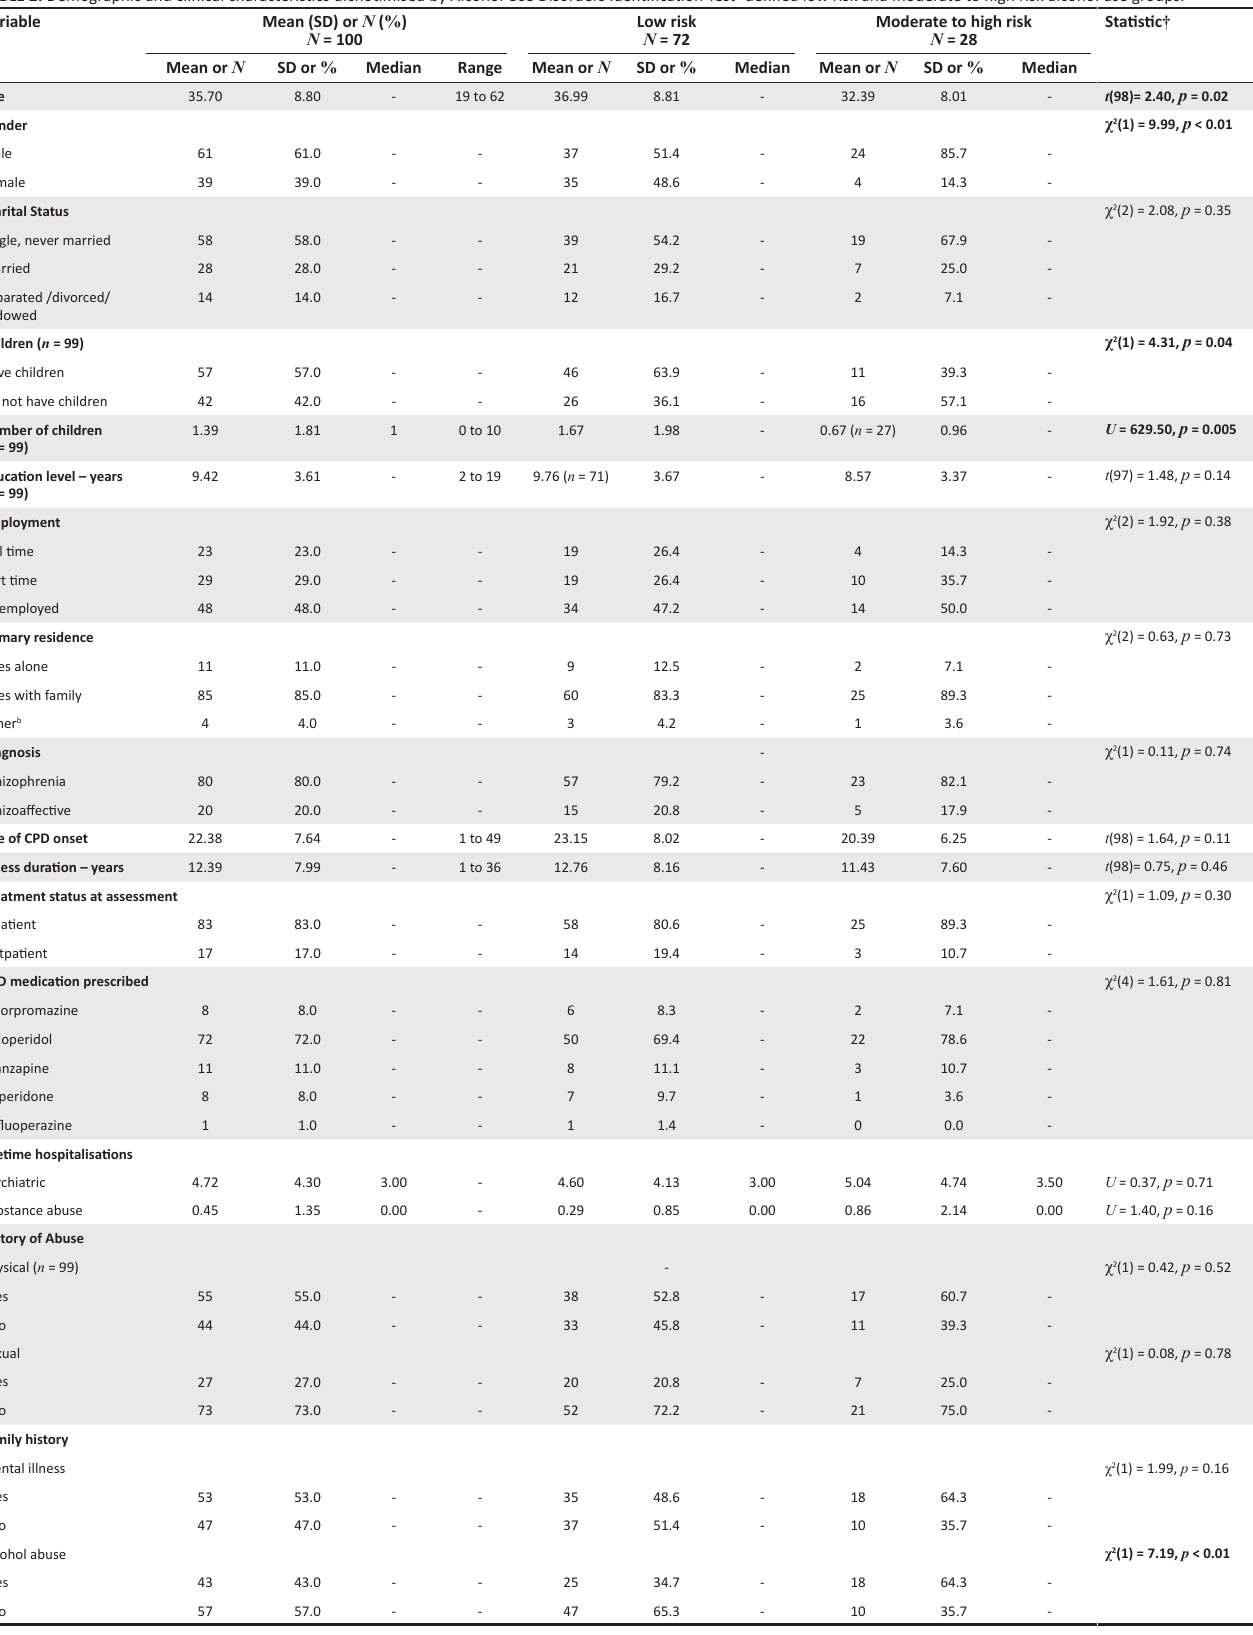
TABLE 2: Demographic and clinical characteristics dichotimised by Alcohol Use Disorders Identification Test -defined low risk and moderate to high risk alcohol use groups. Variable Mean (SD) or N ( % ) Low risk N = 100 N =